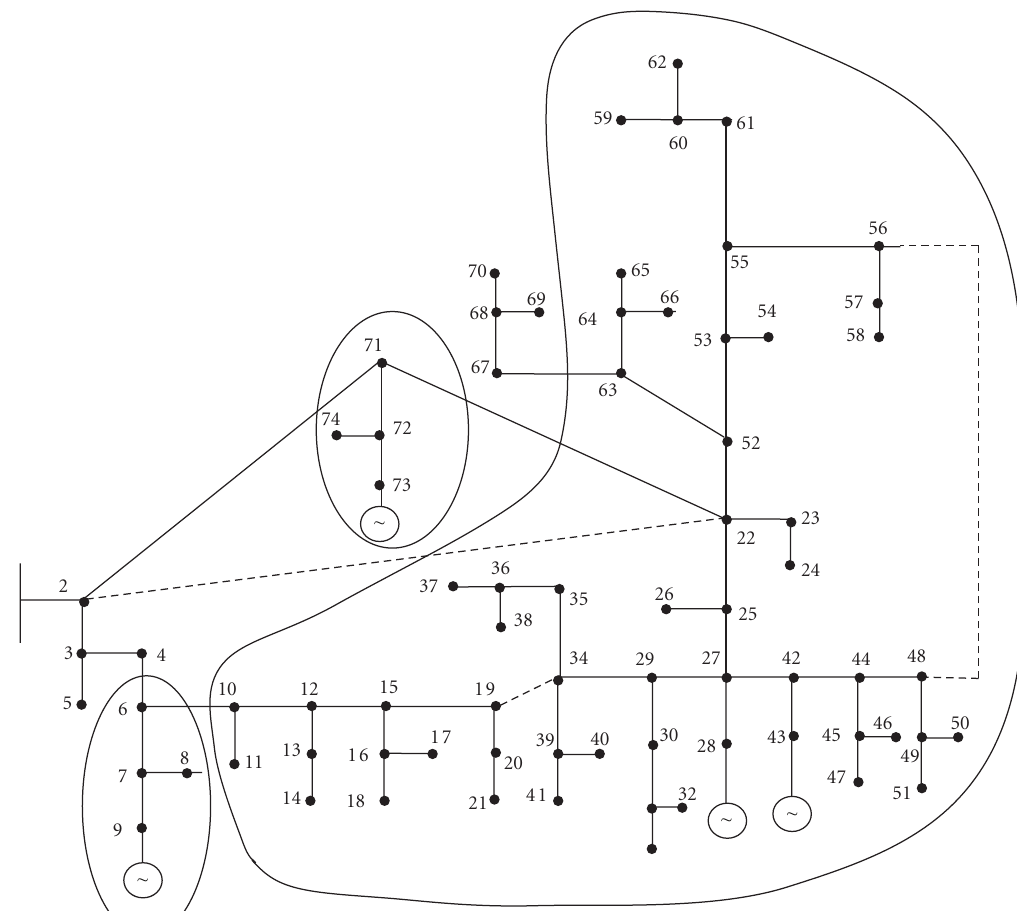
Figure 2: Points of electric network tripping in normal conditions (dashed lines) and composition of islands in the postemergency conditions